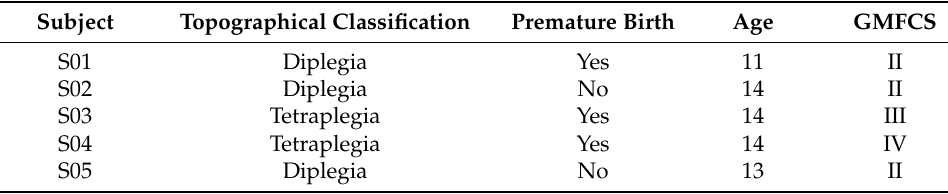
Table 1. Subjects’ demographic